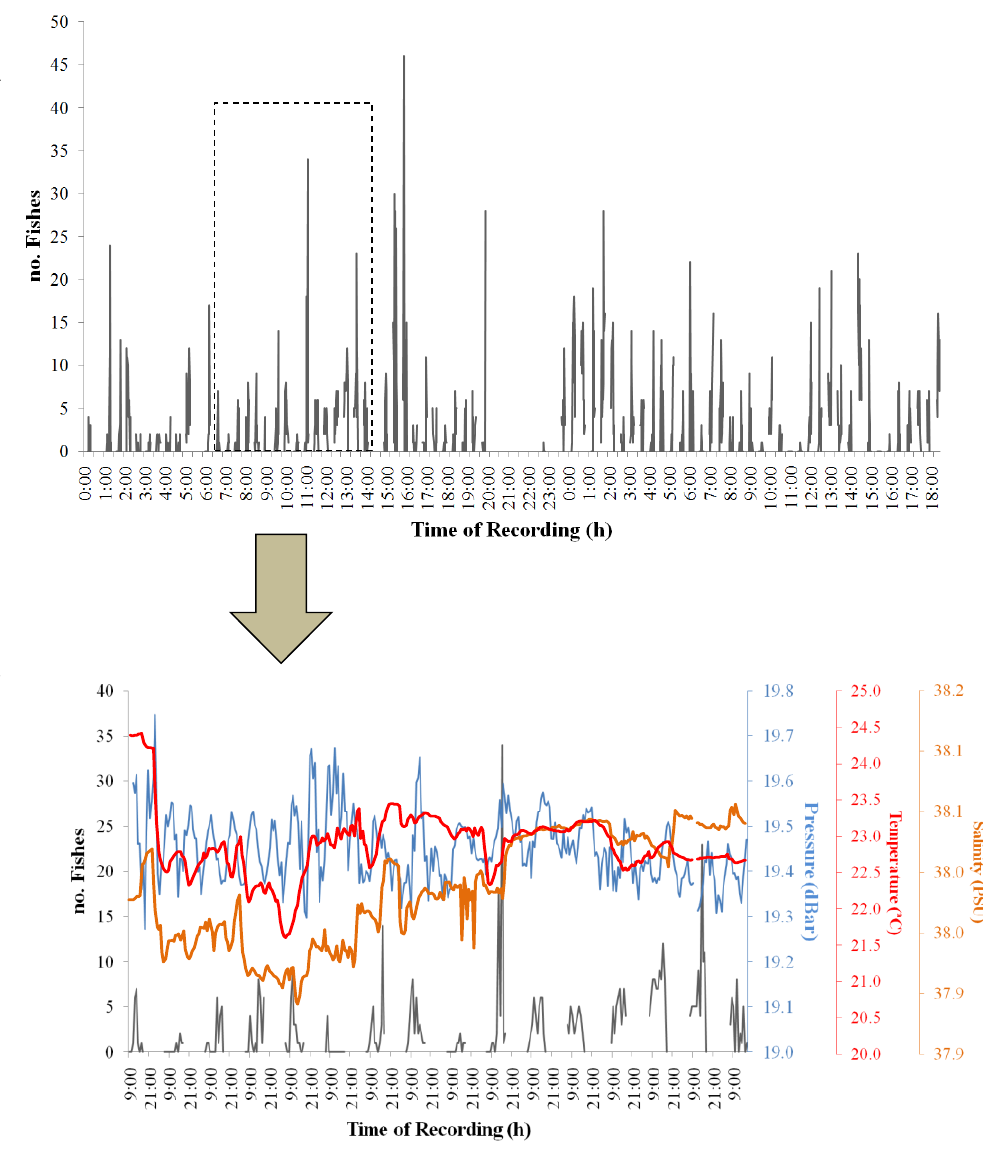
Figure 7. Time series of visual fish counts (black line) as produced by the automated video imaging analysis of still frames acquired by the OBSEA seafloor cabled observatory video imaging system. (A) The whole three-month time series of fish visual fish observations. (B) A 15-day subset (from 18 September to 3 October 2009) is presented (black line) together with corresponding CTD measurements (for a period not included in the previous oceanographic measurements). The latter comparison was performed as an example of potential interdisciplinary multiparametric coupled habitat and bio-data